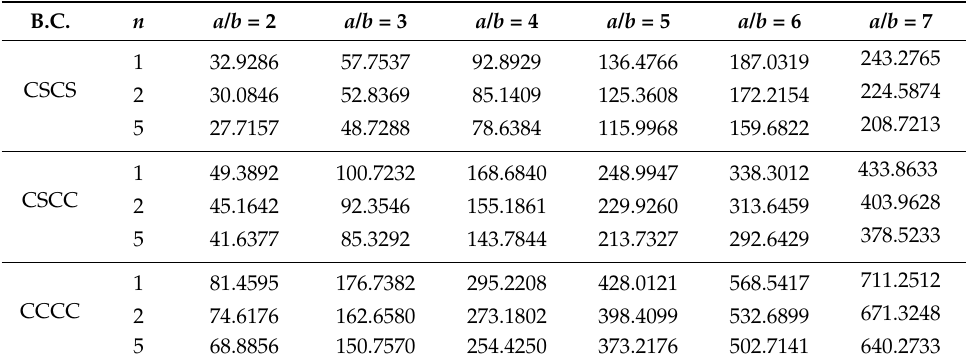
Table 9. Critical buckling temperature ∆ T cr of type-I FGM rectangular thin plate with different a / b and various B.C. under a uniform temperature field ( a / h = 100, T 0 = 300 K). B.C.